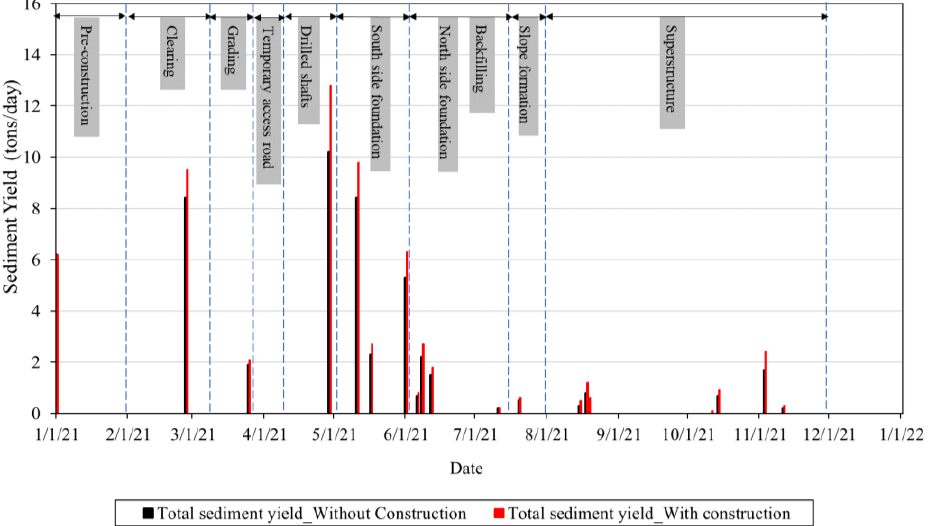
Figure 16. Comparison of with-construction and without-construction daily sediment yields at the Wilson Creek bridge site due to overland erosion and duration of construction activities.